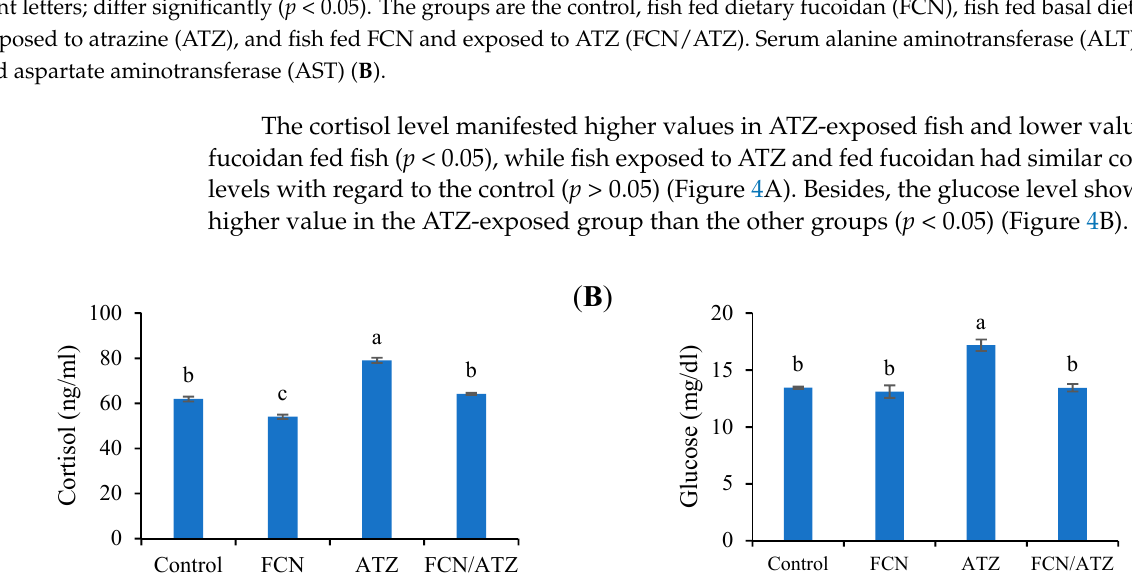
Figure 4. The blood stress factors of Nile tilapia fed fucoidan and exposed to atrazine. Bars present means ± S.E. with different letters; differ significantly ( p < 0.05). The groups are the control, fish fed dietary fucoidan (FCN), fish fed basal diet and exposed to atrazine (ATZ), and fish fed FCN and exposed to ATZ (FCN/ATZ). Blood cortisol ( A ) and glucose ( B ).